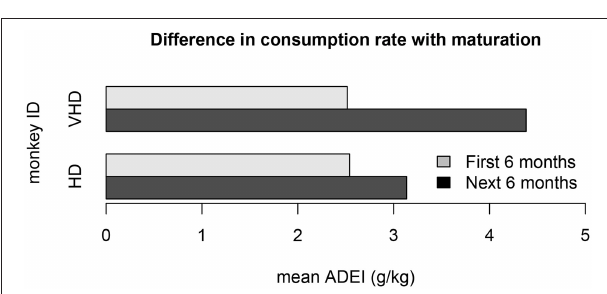
FIGURE 9 | This bar plot shows the difference in ethanol consumption during the first 6 months of open access and the second 6 months of open access for 2 monkeys in cohort 7a. The monkeys matured from adolescence to adulthood during the open access period, which substantially impacted their weight and drinking patterns. The ethanol consumption rate for the first 6 months is different than the second 6 months for all of the monkeys in the cohort. This plot shows the average daily ethanol intake for one very heavy drinker and one heavy